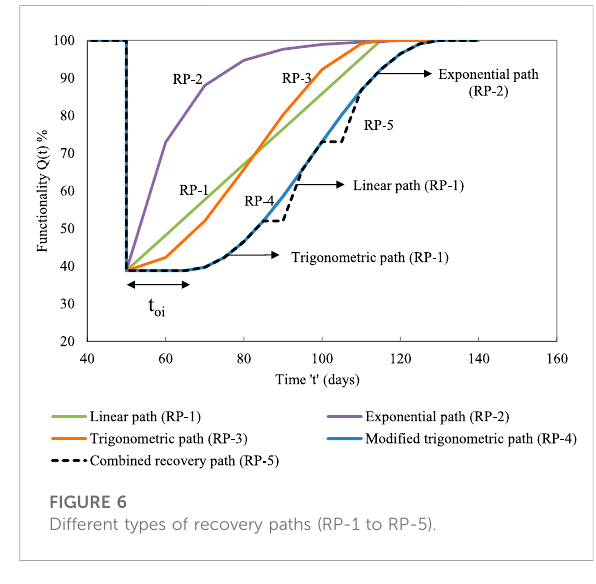
FIGURE 5 Fragility curve for case IV building. FIGURE 6